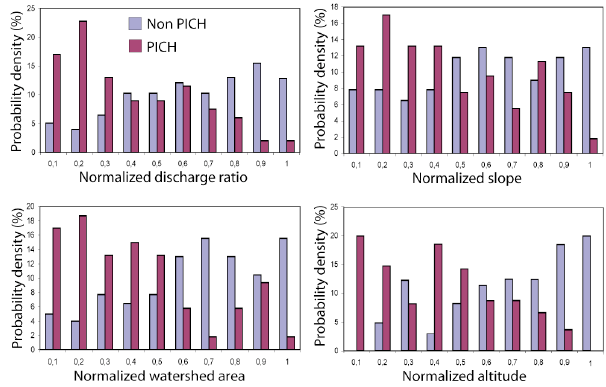
Figure 5. Distribution of the some discriminant factor values for the PICH and Non-PICH sets in the four calibration areas